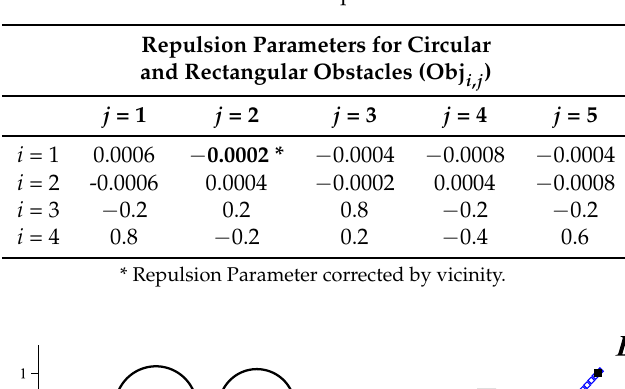
Table 3. Correction of Repulsion Parameters.